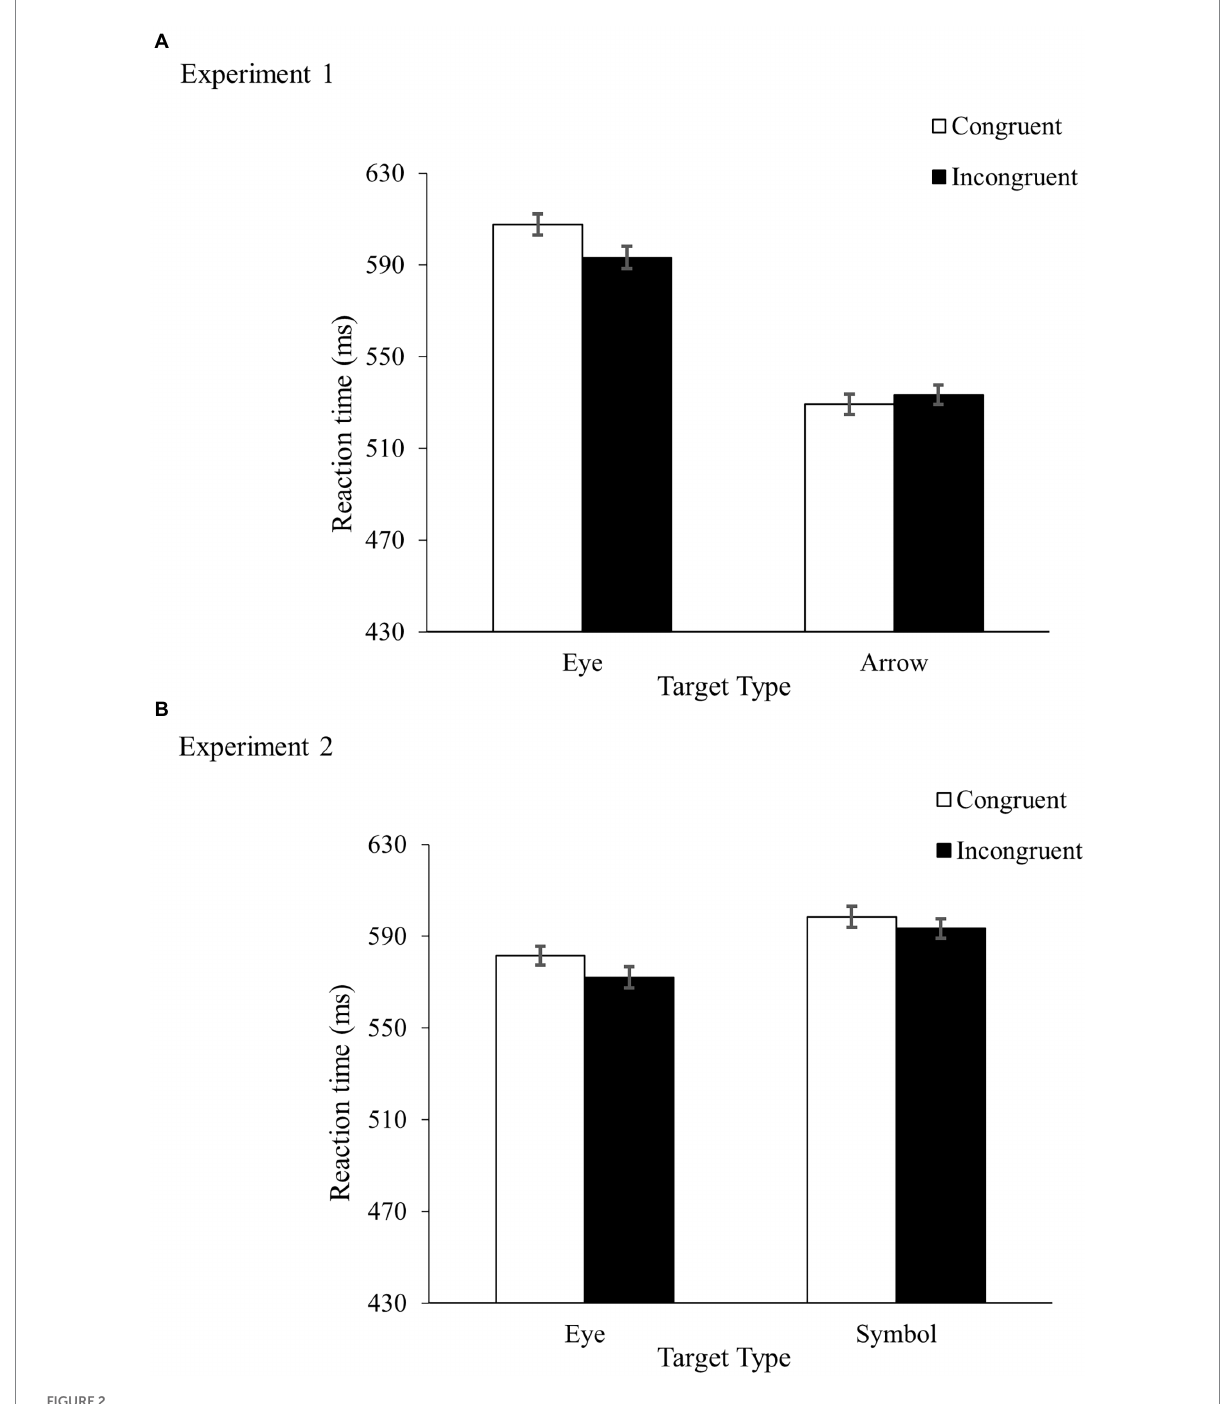
FIGURE 2 Results from Experiment 1 (A) and Experiment 2 (B) . Figures show mean RTs with error bars indicating plus and minus one within-subjects standard error of the